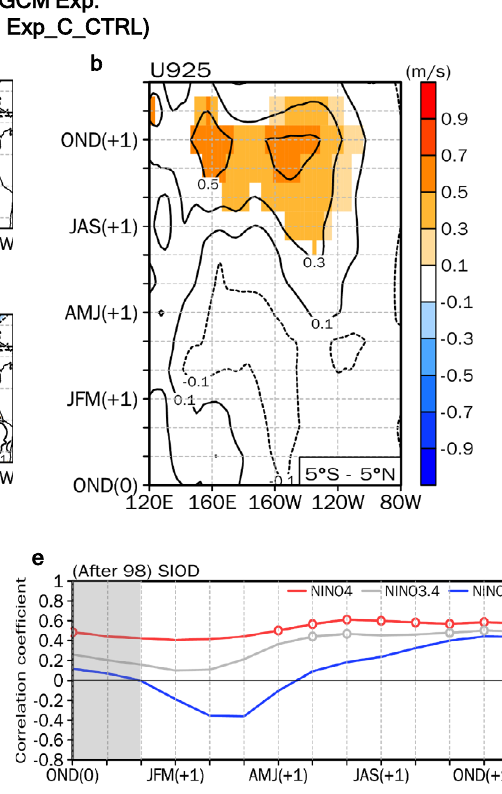
Fig. 4 | Idealized coupled model experiments and correlation skill of the Southern Indian Ocean Dipole index as an ENSO precursor. Changes in the ( a ) precipitation (shading, mmday − 1 ) and 925hPa wind (vector, ms − 1 ), and ( b ) sea surface temperature (SST) (°C) anomalies in the Southern Indian Ocean Dipole (SIOD) experiment (Exp_C_SIOD) compared to the control experiment (Exp_C_CTRL)duringboreallatefall(OND)season. c , d ,Asin a , b ,butforduringthe subsequent year ’ s winter. The shading in a − c denotes the region where the statis- tical signi fi cance is above the 90% con fi dence level. e Hindcast correlation skills of